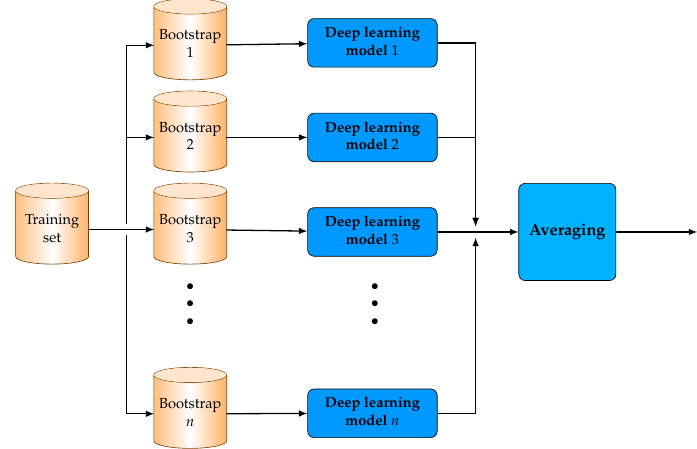
Figure 2. Bagging ensemble of deep learning